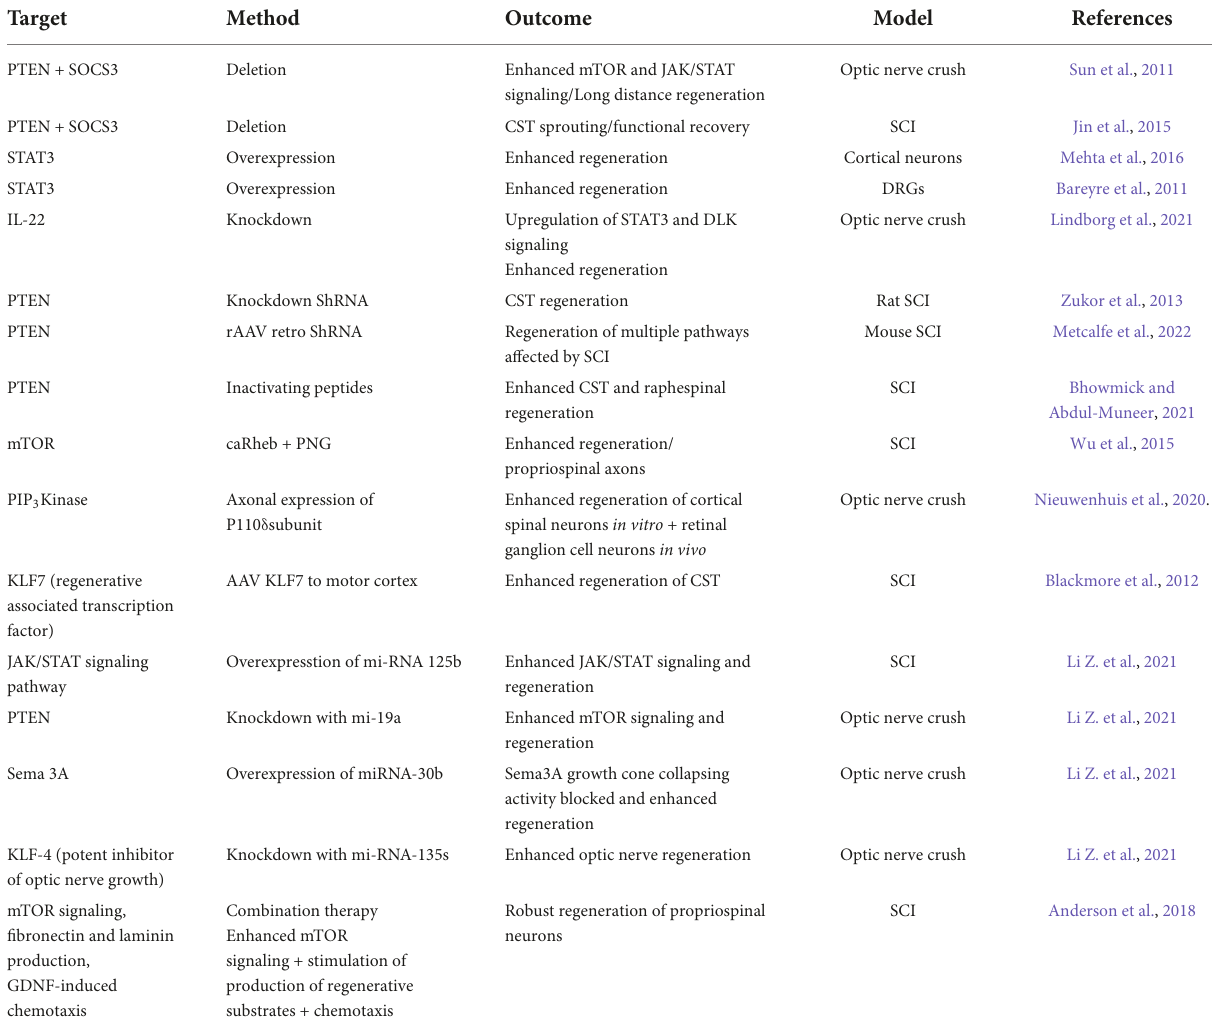
TABLE 1B Interventions targeting neuronal pathways involved in